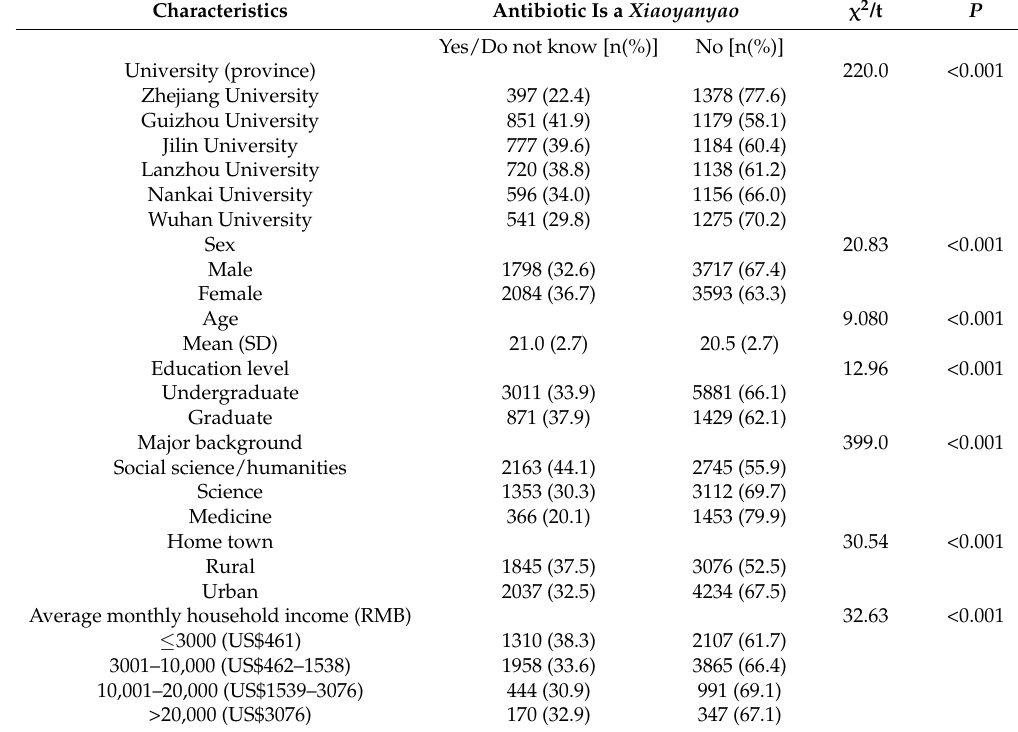
Table 1. The association between socio-demographic characteristics and the misconception (n = 11,192).